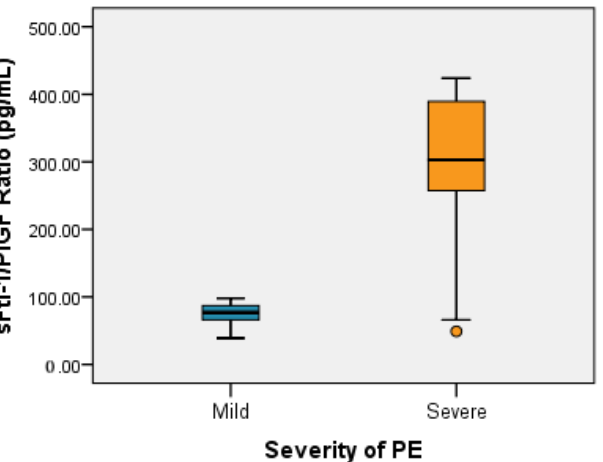
Figure 2. Box–whisker plots representing sFtl1-/PIGF ratio values depending on PE Figure 2. Box – whisker plots representing sFtl1-/PIGF ratio values depending on PE severity.